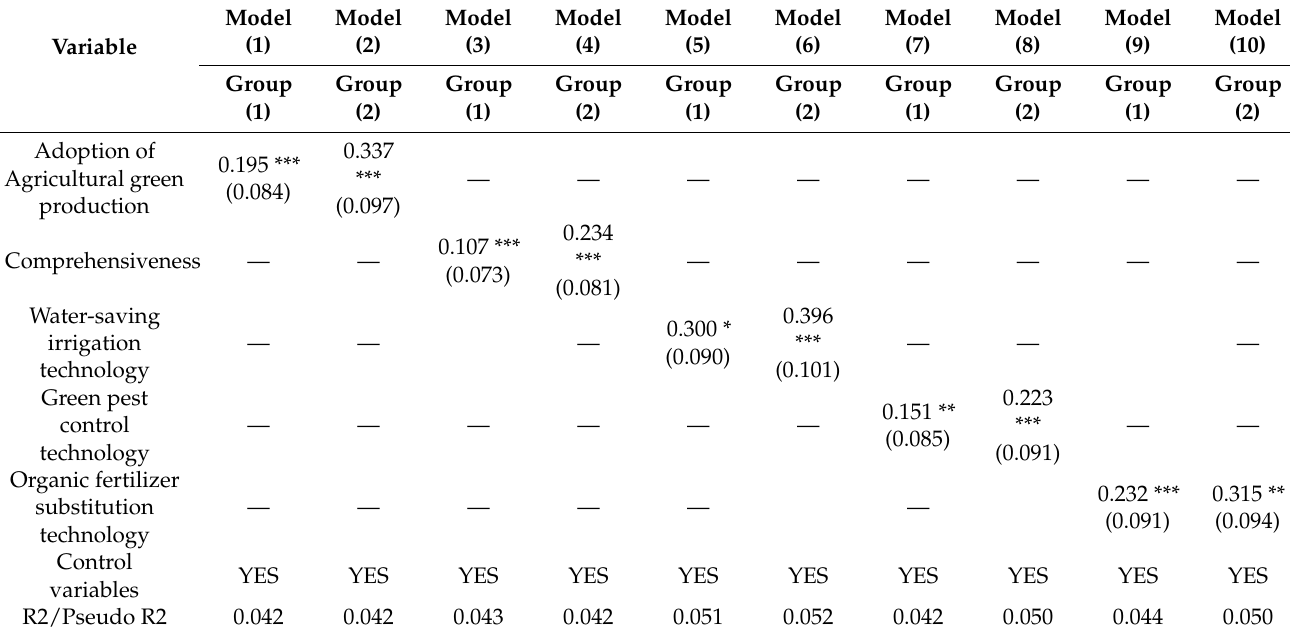
Table 3. Results of empirical analysis based on